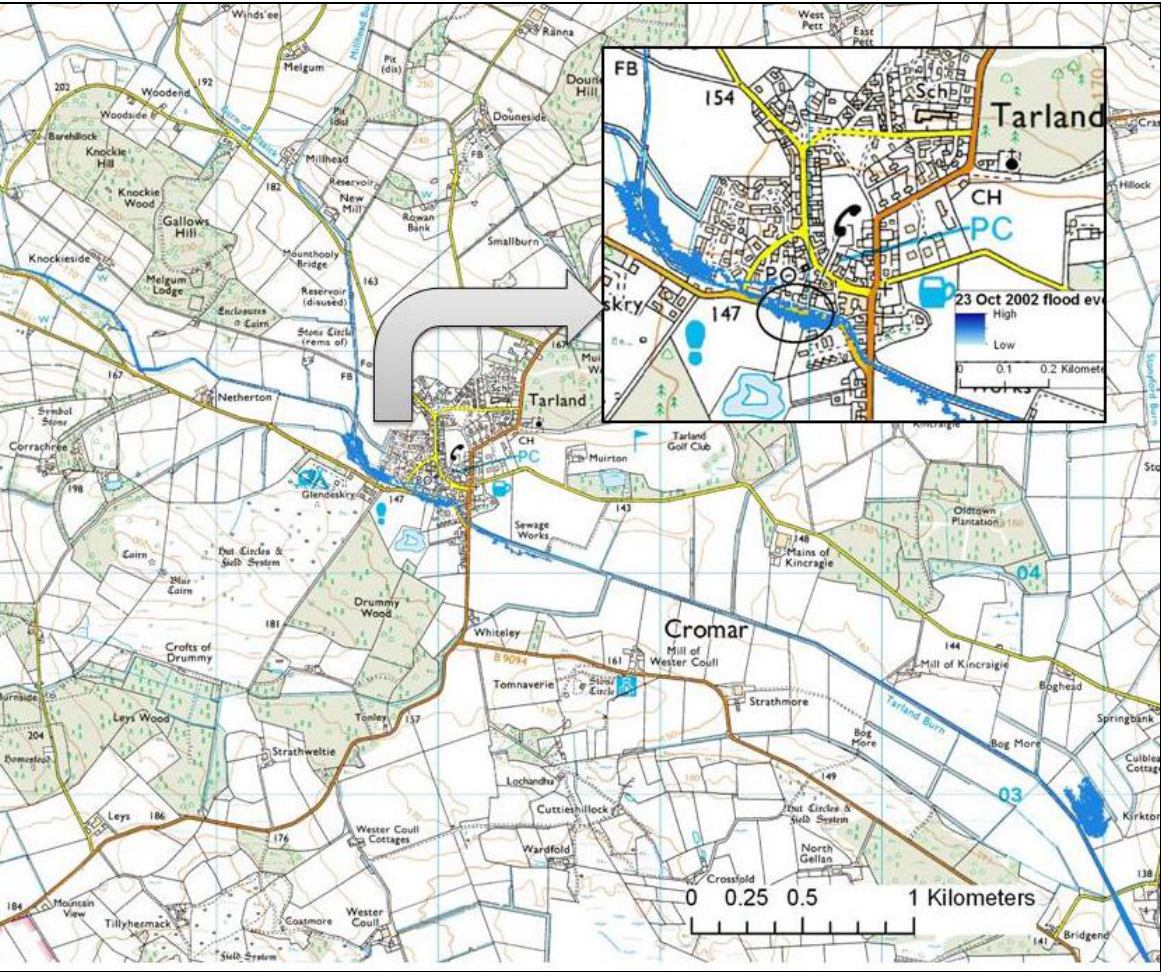
Figure 6. Flood inundation map for the October 2002 flood event. At the centre of the circle is the flood inundation around the Burnside